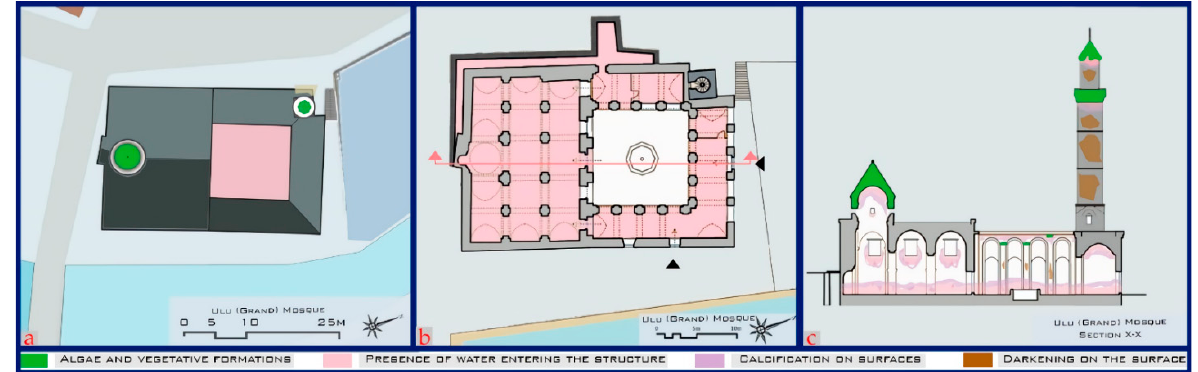
Figure 9. The locations of observed damages; ( a ) layout plan; ( b ) plan; ( c )